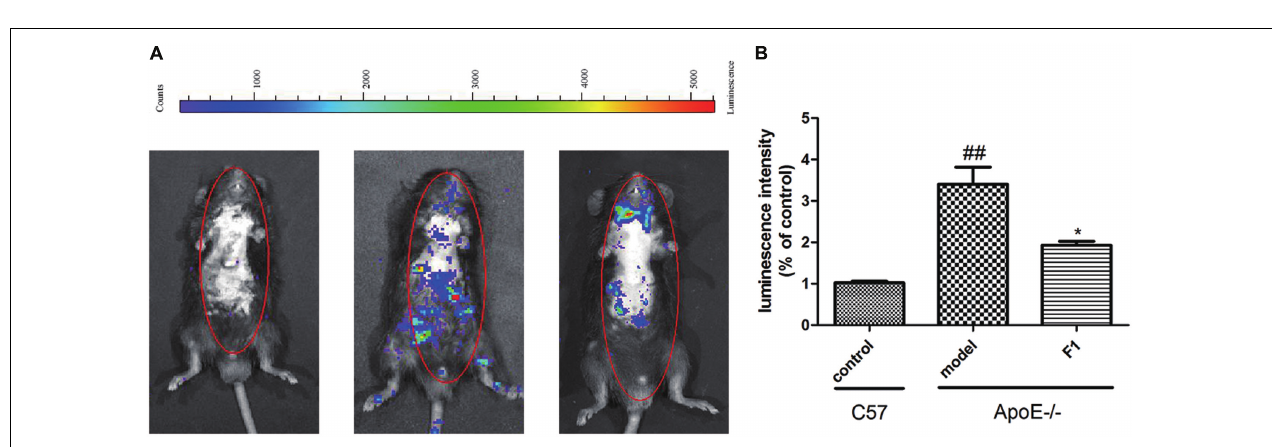
FIGURE 2 | Ginsenoside F1 ameliorated inflammatory responses in HFD-induced ApoE − / − mice. All mice were fed HFD. ApoE − / − mice were treated with GF1 (50 mg/kg/day, i.g.), probucol (2 mg/kg/day, i.g.), or its vehicle (as model group) for 8 weeks; C57 mice were used as the control group. (A) Representative photomicrographs of MPO distribution in the whole body. (B) Statistical analysis of MPO-positive average luminescence intensity. Values ( n = 10 per group) are expressed as the mean ± SD. ## p < 0.01, vs. C57 control group; ∗ p < 0.05 vs. the vehicle-treated ApoE − / − model group.